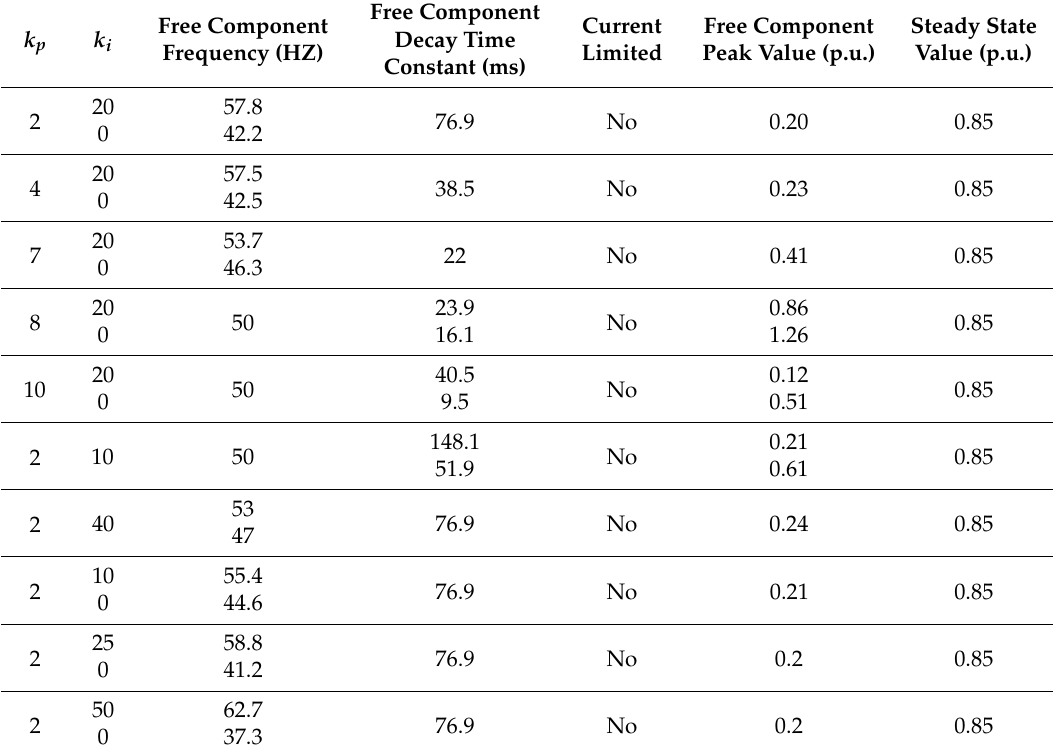
Table 2. Influence of proportional integral (PI) controller